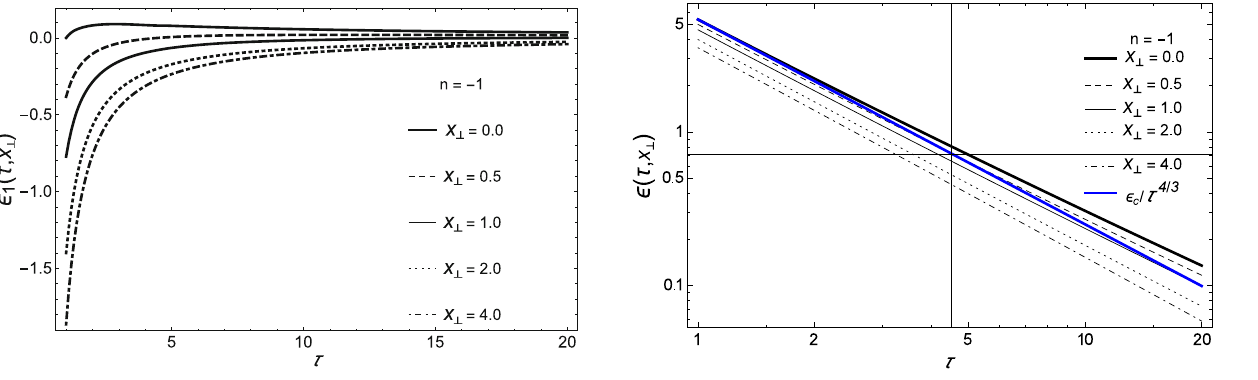
Fig. 8 Log–Log plot of (cid:5)(τ, x ⊥ ) as a function of τ for several values of x ⊥ . The bold blue line shows the dependence (cid:5)/τ 4 / 3 , where (cid:5) is in GeV/fm 3 and τ in fm. We have chosen (cid:5) = 5 . 4 GeV/fm 3 at τ = 1 fm from [2]